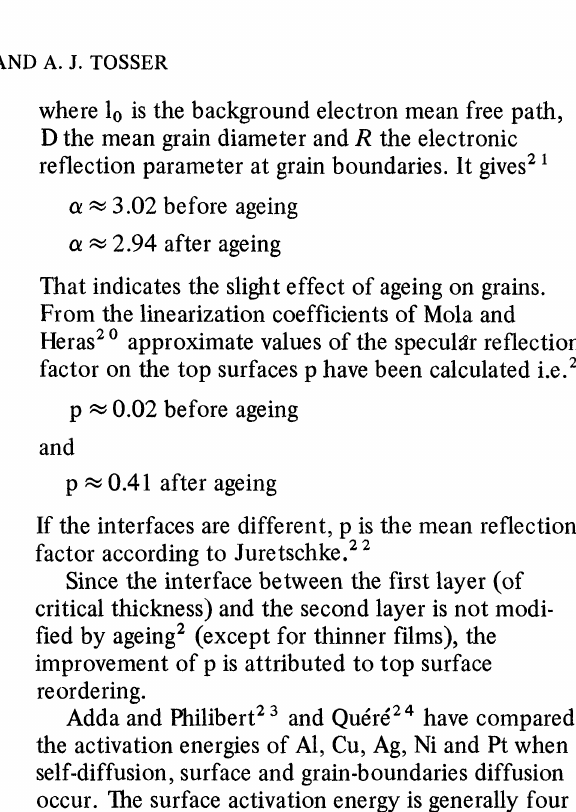
FIGURE 5 Isochronal annealing for 2 h 30 min of AI. films of various thicknesses: Resistance recovery zXR versus the annealing temperature